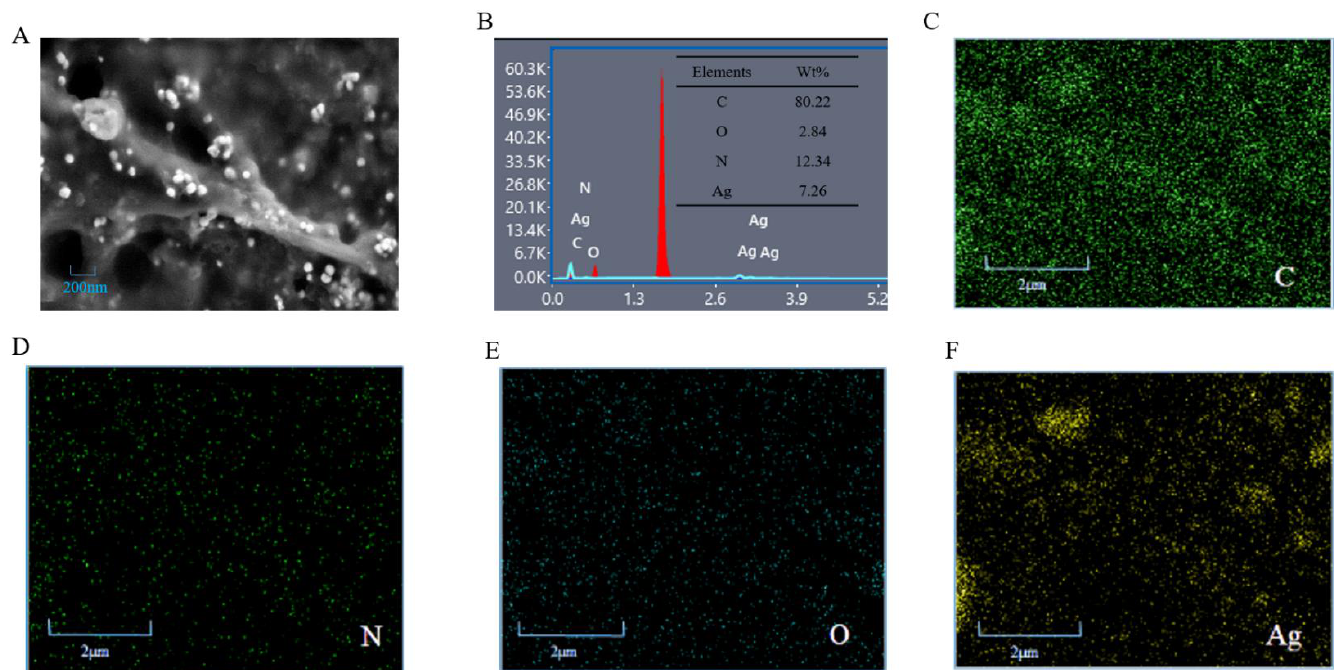
Figure 3. SEM images of the as-synthesized rGO-PEI-Ag ( A ); analysis of the proportion of each element in EDS spectrum ( B ); EDS spectrum of C element ( C ), N element ( D ), O element ( E ), Ag element ( F ) in rGO-PEI-Ag composites.